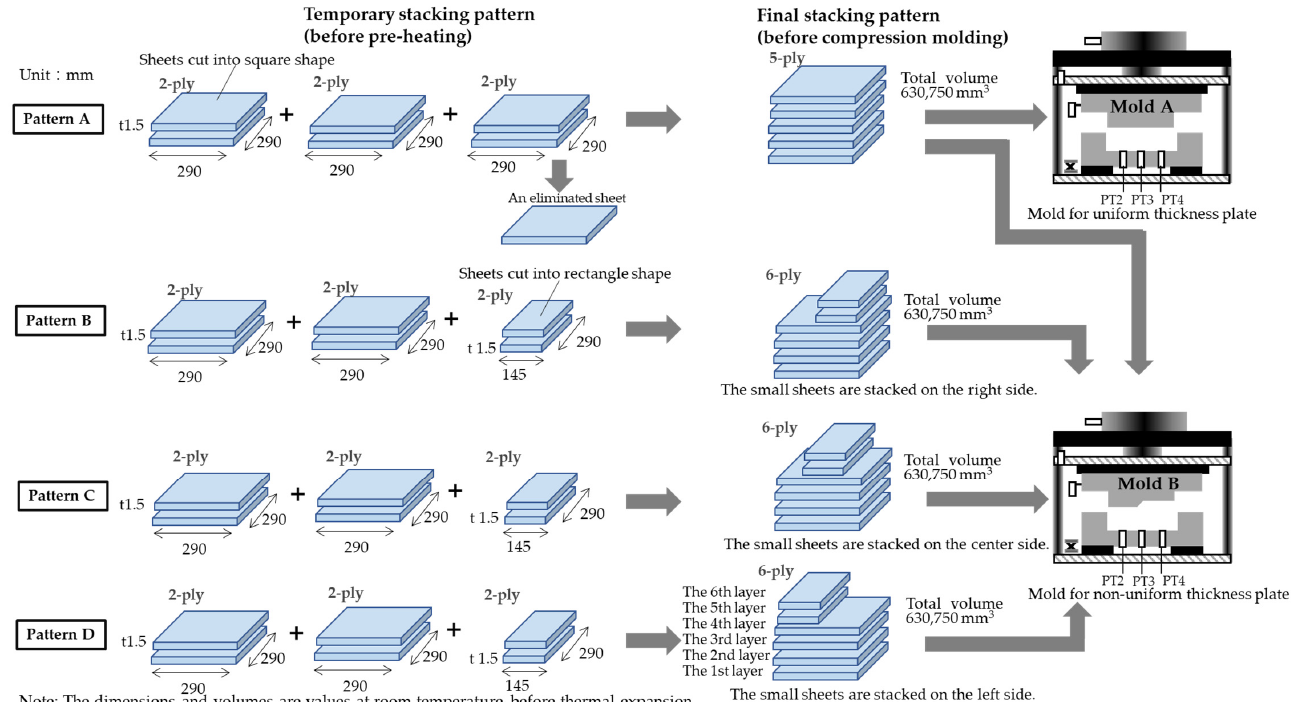
Figure 5. Final stacking patterns of GMT sheets.